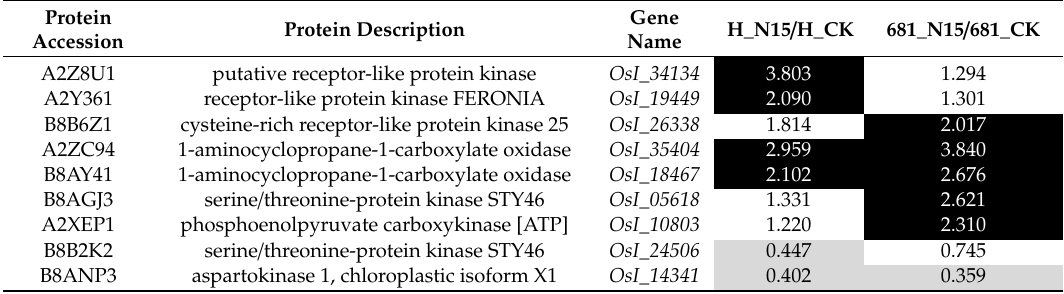
Table 3. The di ff erentially expressed proteins involved in signal transduction in the comparisons